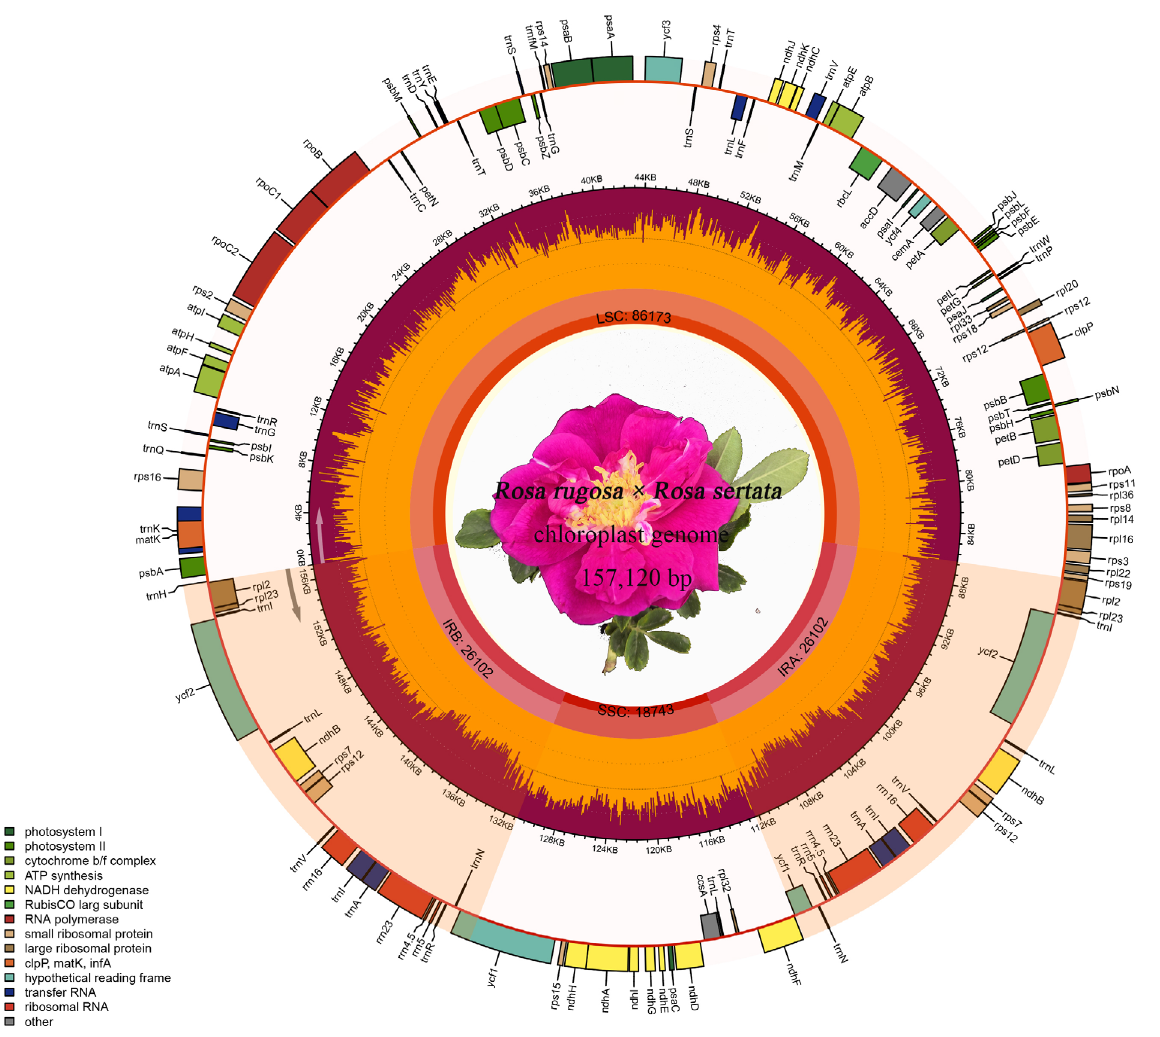
Figure 1 – Gene map of the R. rugosa × R. sertata chloroplast genome. The genes with different functional classification are color coded and the pseudogene is marked asterisks. The genes are shown inside and outside the outermost layer represented with transcription directions clockwise